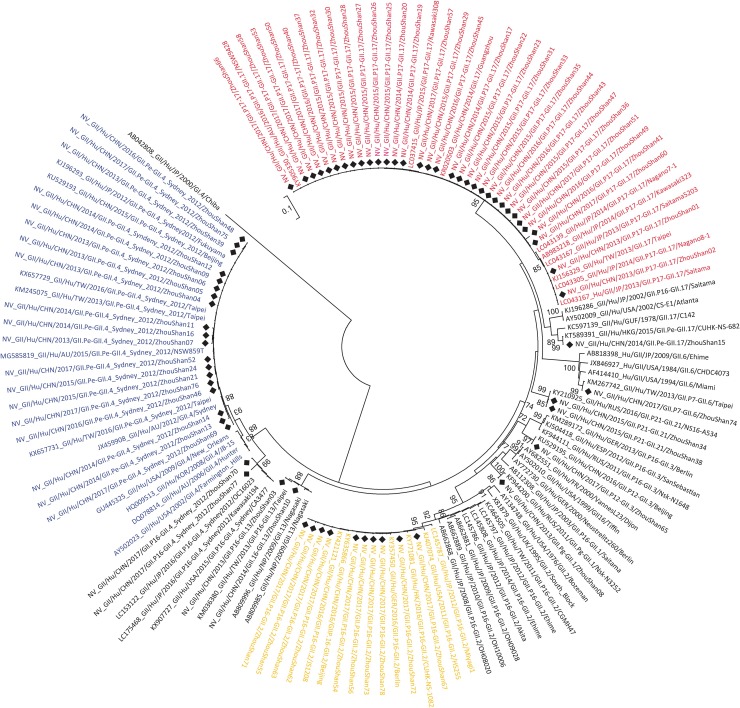
Phylogenetic analyses of 77 sequences of HuNoV strains based on partial RdRp and VP1 gene regions.Trees were generated using the Neighbor-Joining (NJ) method and genetic distances were calculated using the Kimura 2-parameter + Gamma substitution model employed in MEGA v.7.0. Bootstrap values (>70%) are shown at the corresponding branches. HuNoV strains isolated in this study are marked with solid black diamonds. Blue represents GII.Pe-GII.4_Sydney_2012, red represents GII.P17-GII.17, yellow represents GII.P16-GII.2.